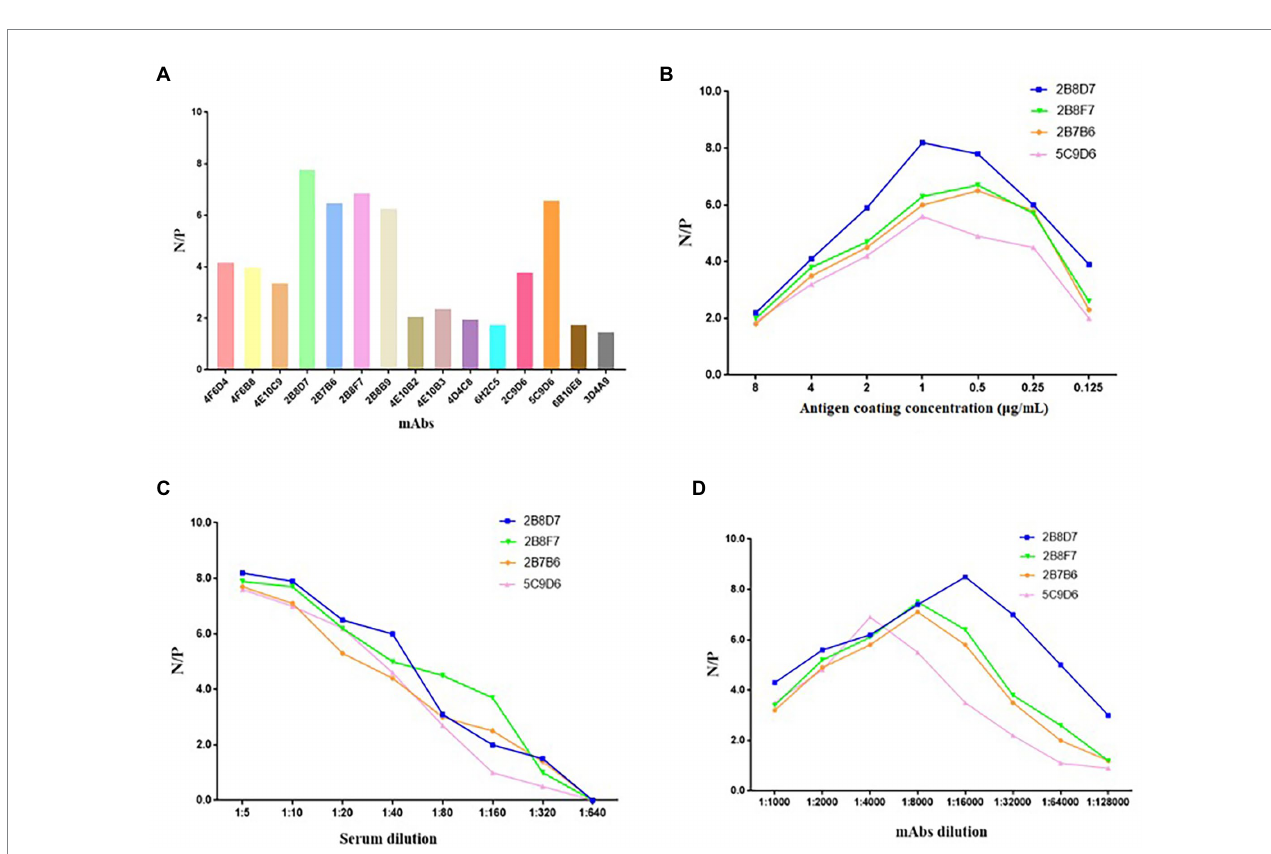
FIGURE 9 Screening of mAbs for ASFV diagnosis. (A) The 17 mAbs were preliminarily selected based on their N/P ratios in the same conditions of antigen coating concentration of 0.25 μ g/ml, hybridoma cell supernatant dilution of 1: 5, and serum dilution of 1: 10. (B) N/P ratios of the four selected mAbs at different coating concentrations. (C) N/P ratios of the four mAbs at different dilutions of sera in the condition of optimum coating concentrations (1 μ g/ml of 2B8D7 and 2B8F7, 0.5 μ g/ml of 2B7B6 and 5C9D6). (D) N/P ratios of the four mAbs at different dilutions in the condition of optimum coating concentrations of antigens (1 μ g/ml of 2B8D7 and 2B8F7, 0.5 μ g/ml of 2B7B6 and 5C9D6) and optimum serum dilution